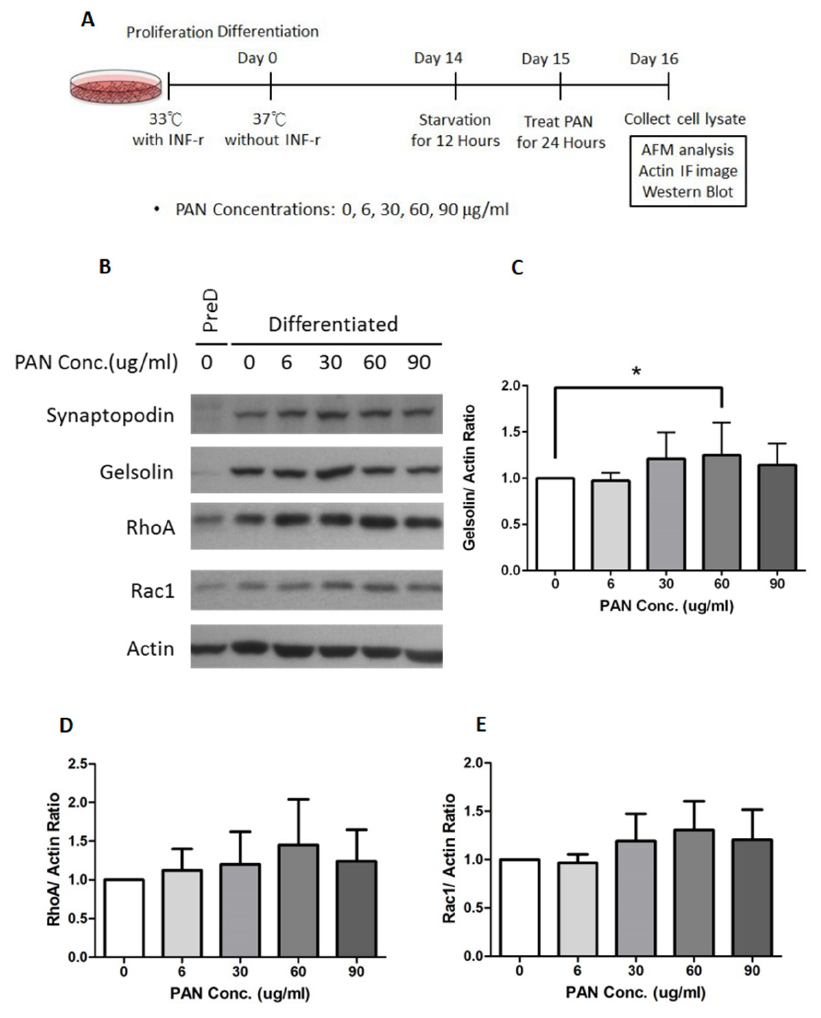
Figure 4. Protein expression by PAN-treated podocytes examined by Western Blot. ( A ). Podocyte cells were cultivated at 33 °C with 5% CO 2 to allow proliferation, and then at 37 °C for 14 days to induce differentiation. After starvation for 12 h, podocytes were treated with different concentrations of PAN for 24 h, and subsequently analyzed. (PAN = Puromycin aminonucleoside). ( B ). Expression of the proteins synaptopodin, gelsolin, RhoA, Rac1, and actin after PAN treatment were demonstrated by Western Blot. ( C ). Relationship between gelsolin: actin ratio and PAN concentration. Histograms represent mean ± SEM. Data were analyzed by one-way ANOVA. ( D ). Relationship between RhoA: actin ratio and PAN concentration. Histograms represent mean ± SEM. Data were analyzed by one-way ANOVA. ( E ). Relationship between Rac1: actin ratio and PAN concentration. Histograms represent mean ± SEM. Data were analyzed by one-way ANOVA. * p <